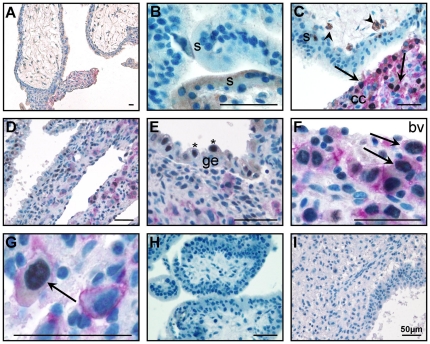
Dipeptidyl peptidase 1 (DPP1; brown) and HLAG (pink) co-localization in placental villous (A–C) and decidua basalis (D–G).A. DPP1 localization in placental villous. B. DPP1 localized to some areas of syncytiotrophoblast (s). C. DPP1 and HLAG co-localilzed to extravillous trophoblast (EVT) in the cell column (cc) (arrows). DPP1 staining was predominantly peri-nuclear in EVT. DPP1 localized to leukocytes in the placental villous stroma (arrowheads). D. DPP1 localization in the decidua. E. DPP1 localized to the glandular epithelium (ge), with peri-nuclear localization observed in some cells (*). F. DPP1 localized to iEVT (arrows) surrounding remodelled blood vessels (bv). G. DPP1 localization in iEVT (arrow). DPP1 localization in iEVT was predominantly peri-nuclear. H. Negative (IgG) control for placental villous. I. Negative (IgG) control for decidua. Scale bar: 50 µm.